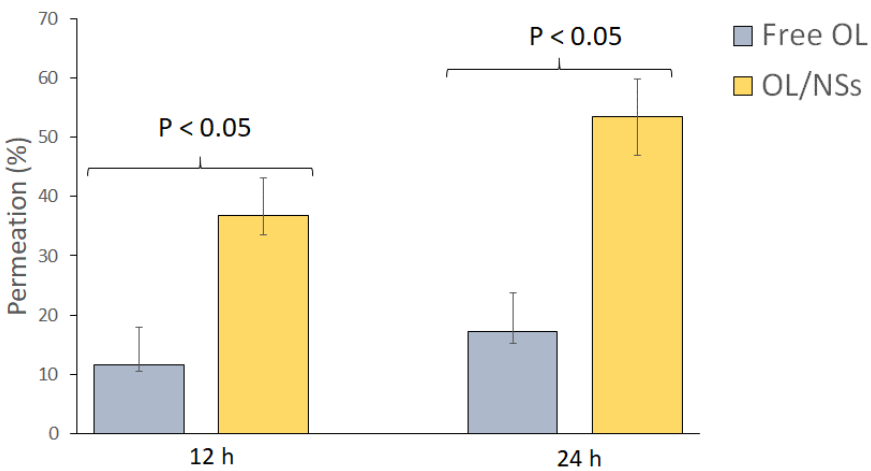
Figure 5. Ex-vivo skin permeation study of OL and OL/NSs.